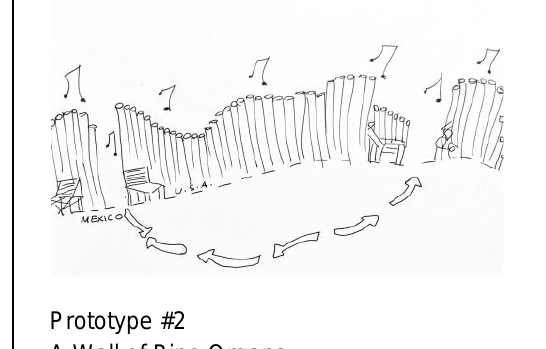
Figure 4 J. M. Design Studio, “Prototype #2 A Wall of Pipe Organs” from The Other Border Wall Proposals (2017). Digital scanned image of ink drawing on paper, text. 8 ½ X 11 inches. Collection of J. M. Design Studio.